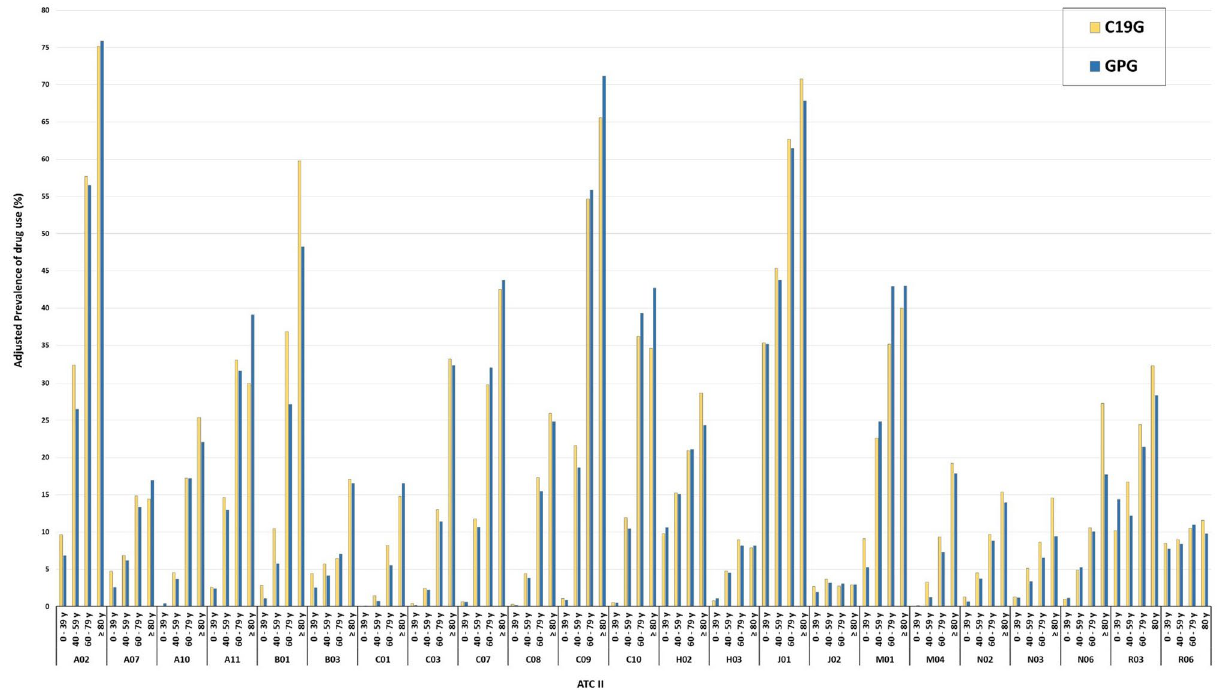
Figure 2. Prevalence of drug use between the C19G and GPG stratified by age group. C19G COVID-19 group; GPG general population group